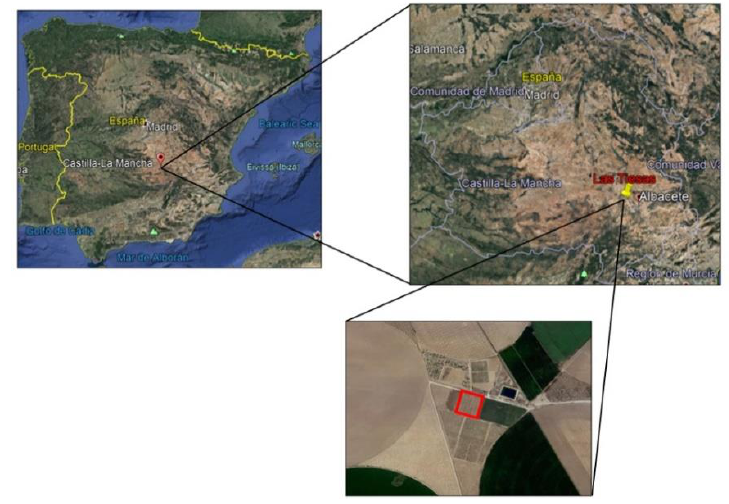
Figure 1. Location of the Study Area [39].